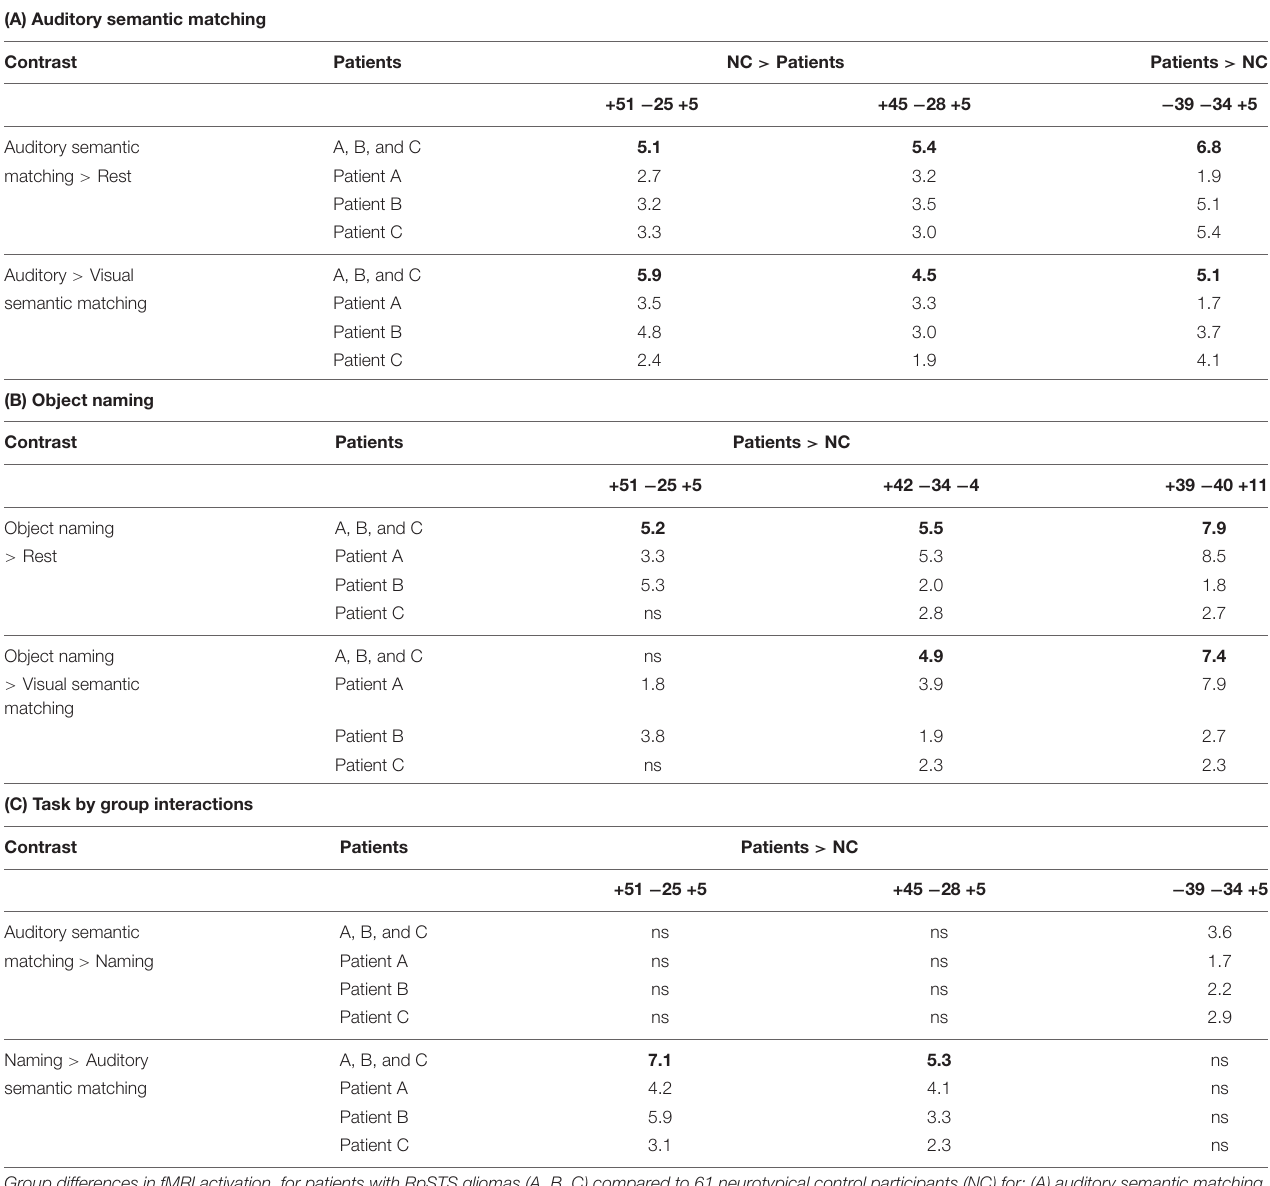
TABLE 5 | Comparison of patients with RpSTS gliomas to neurotypical control